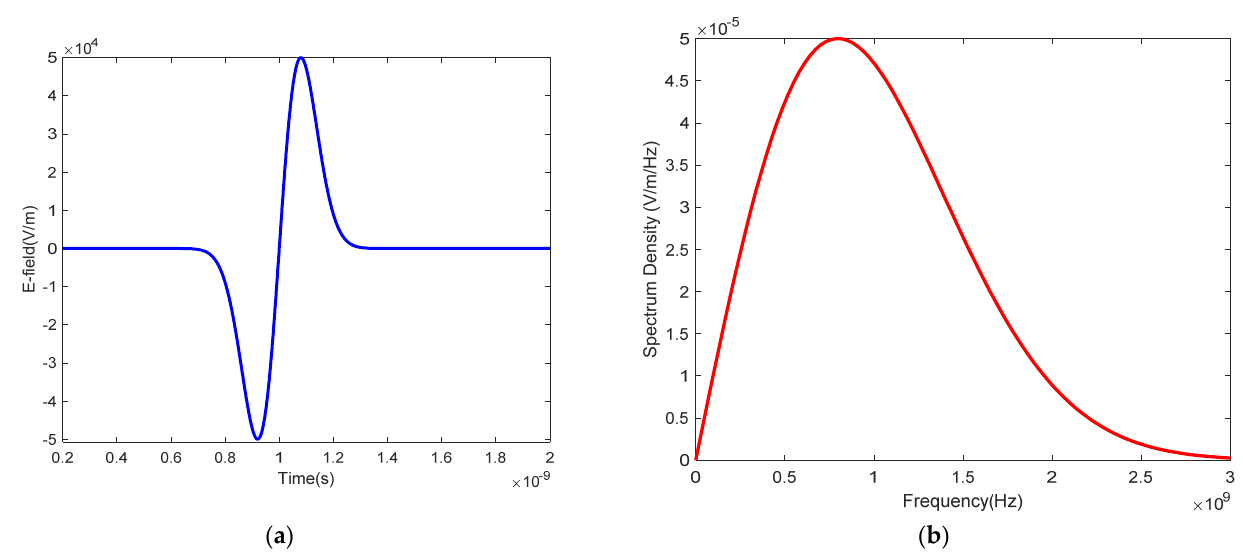
Figure 4. UWB waves: ( a ) time domain; ( b ) frequency domain.